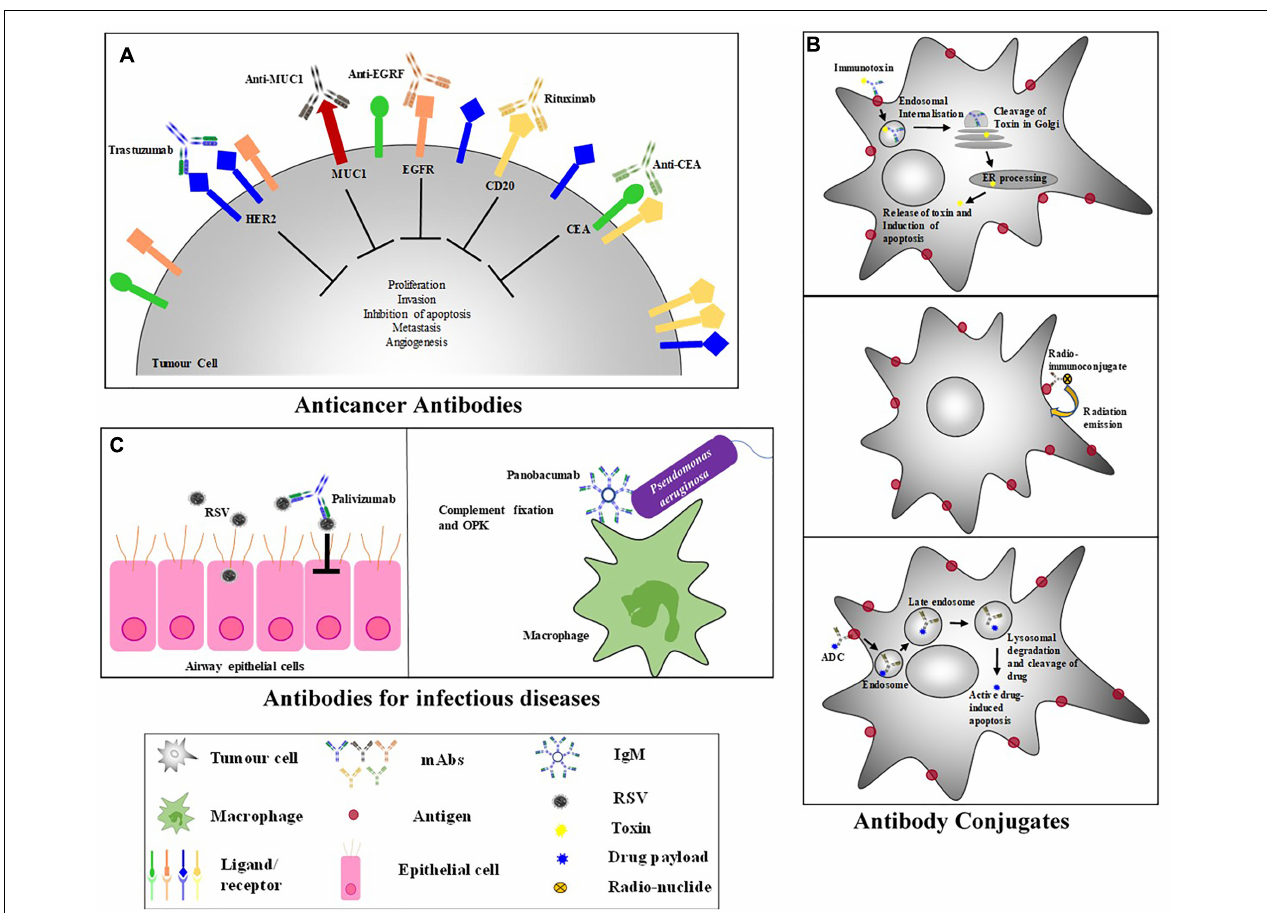
FIGURE 3 | Antibody-Based Therapeutic Strategies. (A) Anticancer antibodies eliminate cancer cells and cause tumor destruction by targeting cancer antigens. (B) Antibody-conjugates – (i) Immunotoxins: bind to a surface receptor of an infected cell, undergo endocytosis and intracellular trafficking to the cytosol where most toxins induce cell death; (Becker and Benhar, 2012) (ii) ADCs: combine the specificity of mAbs with the cytotoxic potential of drugs and binds to internalizing receptors on target cell and are taken up by endocytosis; Once in the cell, ADCs undergo cellular trafficking to a lysosome where lysosomal degradation results in the cleavage and release of the active drug into the cellular cytoplasm where the drug induces apoptosis; (Scotti et al., 2015) (iii) Radioimmunoconjugates: antibodies attached to a radioactive molecule, once the antibody binds the target cell, the radio-particle’s radiation interacts with target cells, resulting in cell death. (C) Anti-viral antibodies – to eliminate a viral inhibition of cell infection, viral replication, cell-cell transmission, viral release as well as mediated killing of infected cells needs to occur; Palivizumab is a neutralizing antibody that binds to RSV preventing virus-host cell interactions (Groothuis and Nishida, 2002). Most antibacterial therapeutic mAbs function by inducing complement fixation and opsonophagocytic killing (OPK) of target bacteria; Panobacumab induces macrophage OPK of Pseudomonas aeruginosa (Que et al.,